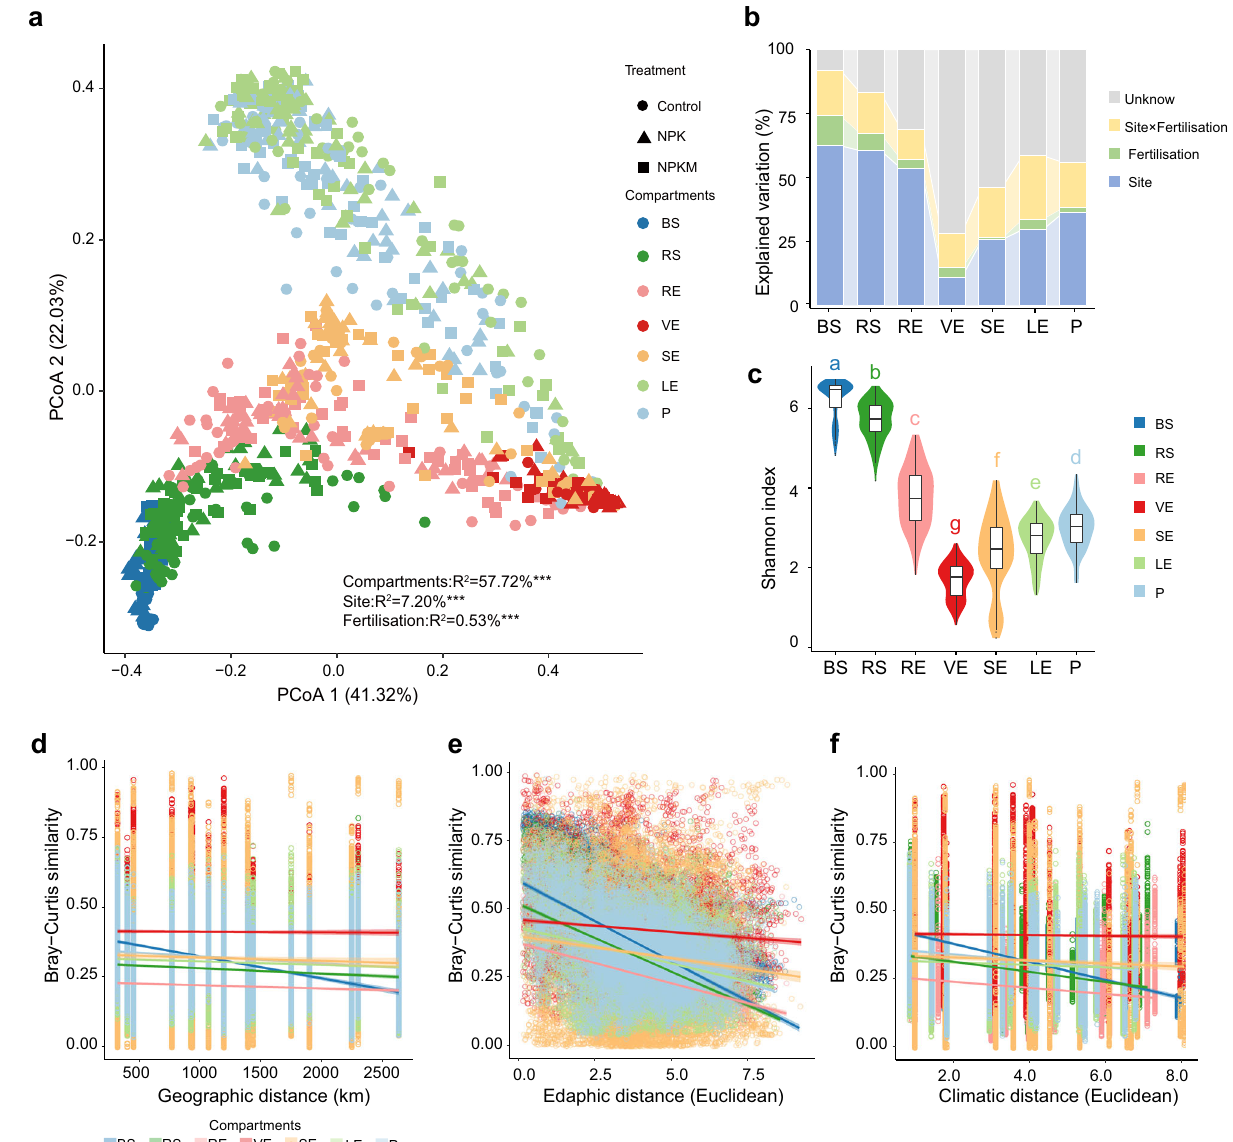
Fig. 1 Effects of soil type and fertilisation on the maize microbiome. a Unconstrained principal coordinates analysis (PCoA) with weighted unifrac distance across the whole dataset. (*** P < 0.001, PerMANOVA by Adonis). Control: no fertilisation; NPK: chemical fertiliser nitrogen, phosphorus, and potassium; NPKM: organic manure plus chemical fertiliser; BS: bulk soil; RS: rhizosphere soil; RE: root endosphere; VE: xylem sap; SE: stem endosphere; LE: leaf endosphere; P: phylloplane. b Effects of site, fertilisation treatments, and site × fertilisation on bacterial community structure in each compartment as tested by PerMANOVA. c Violin plot showing distribution of Shannon ’ s index of the bacterial community in each compartment. Horizontal bars within boxes denote medians. Tops and bottoms of boxes represent 25th and 75th percentiles, and lines extend to the 1.5× interquartile range. Letters indicate statistical signi fi cance among groups using two-sided Wilcoxon test (adjusted P < 0.05 by Benjamini and Hochberg method). The sample sizes are as follows: BS, 126; RS, 141; RE, 138; VE, 119; SE, 120; LE, 158; P, 152. d – f , Distance-decay curves showing Bray – Curtis similarity against geographic distances ( d ), edaphic distances ( e ), and climatic distances ( f ). Solid lines represent ordinary least-squares linear regressions. Source data and exact P values are provided in the Source Data fi